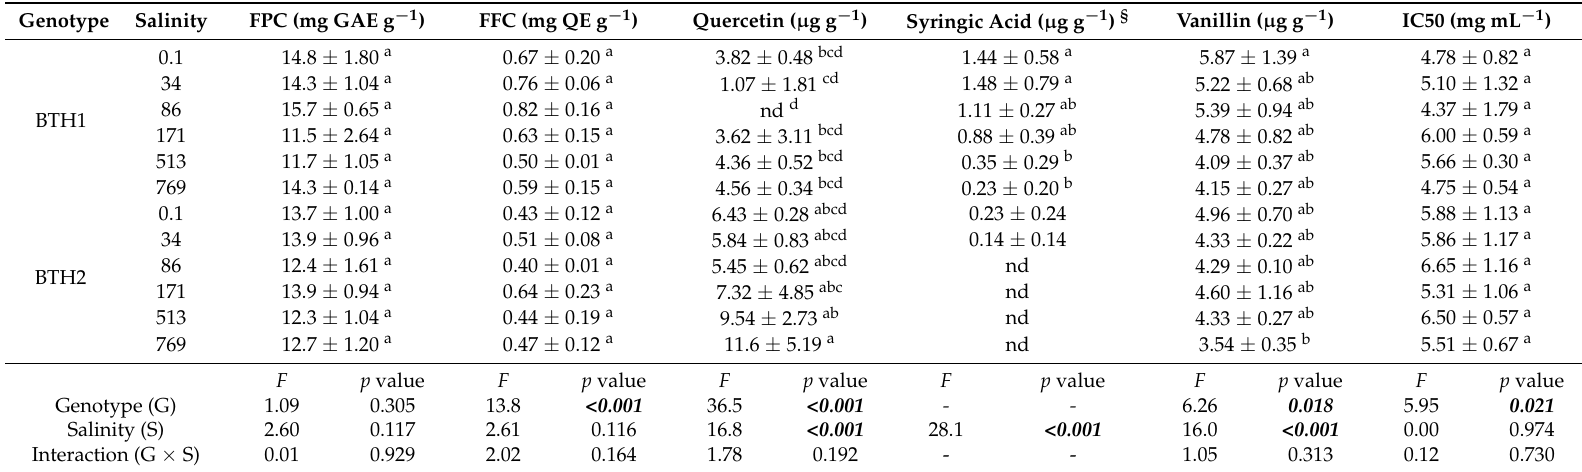
Table 4. Averages ( ± standard deviation) of phenolic compounds’ contents and antioxidant capacity of shoots (dry weight) of Salicornia neei genotypes (BTH1 and BTH2) after 50 days of cultivation in greenhouse at different salinities (0.1, 34, 86, 171, 513 and 769 mM